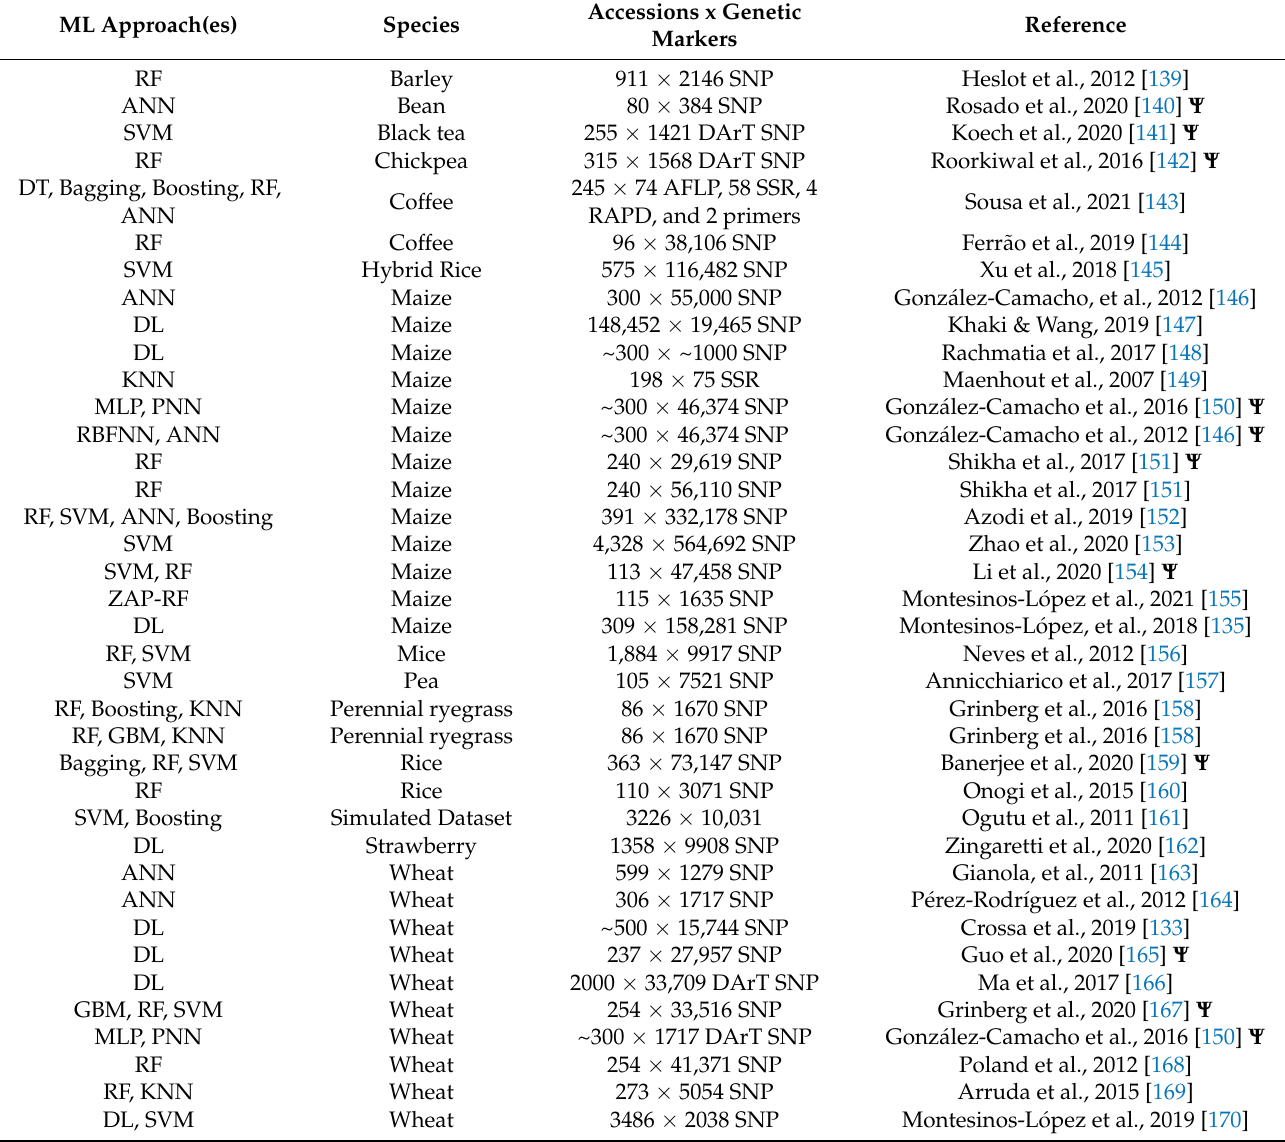
ML tool abbreviations as follows: adaptive boosting (AdaBoost), artificial neural networks (ANN), decision tree (DT), deep learning (DL), extreme gradient boosting (XGBoost), gradient boosting machines (GBM), multilayer perceptron neural network (MLP), probabilistic neural network (PNN), radial basis function neural network (RBFNN), random forest (RF), support vector machines (SVM), and zero altered Poisson random forest (ZAP-RF). ML-coupled genomic prediction initiatives explicitly related to abiotic stress tolerance are marked with Ψ under